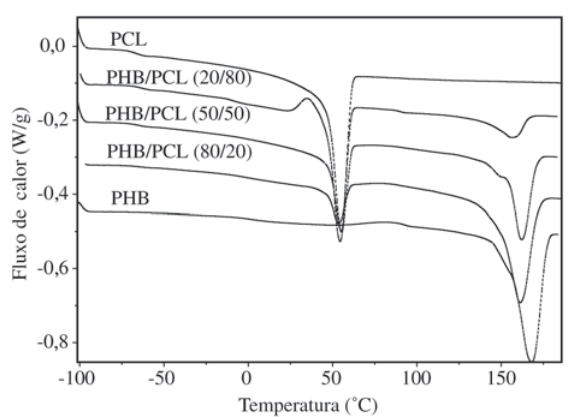
Figura 7. Temperaturas de transição vítrea do P(3-HB) e da PCL em função da % de PCL na blenda.